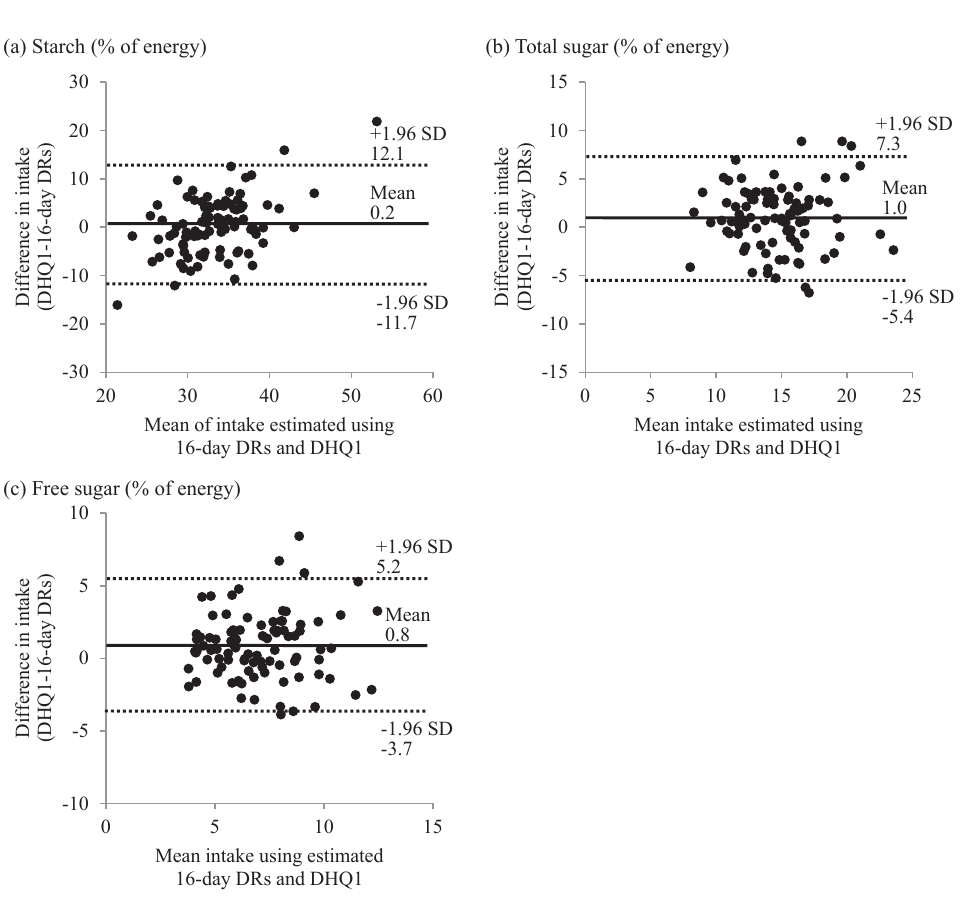
Figure 1. Brand-Altman plots between energy-adjusted intake (% of energy) of starch and total and free sugars estimated by 16- day DRs and that estimated by DHQ1 in 92 women; DRs, dietary records; DHQ1, fi rst self-administered diet history